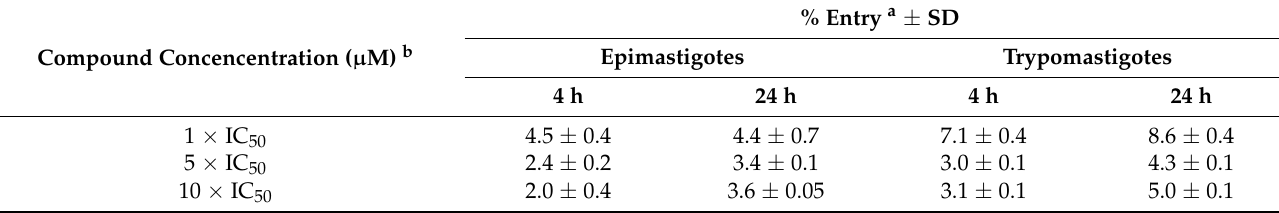
Table 2. Calculated percentages of vanadium uptaken by the parasites for [V V O(IN-2H)(L2-H)]. Compound Concencentration ( µ M)